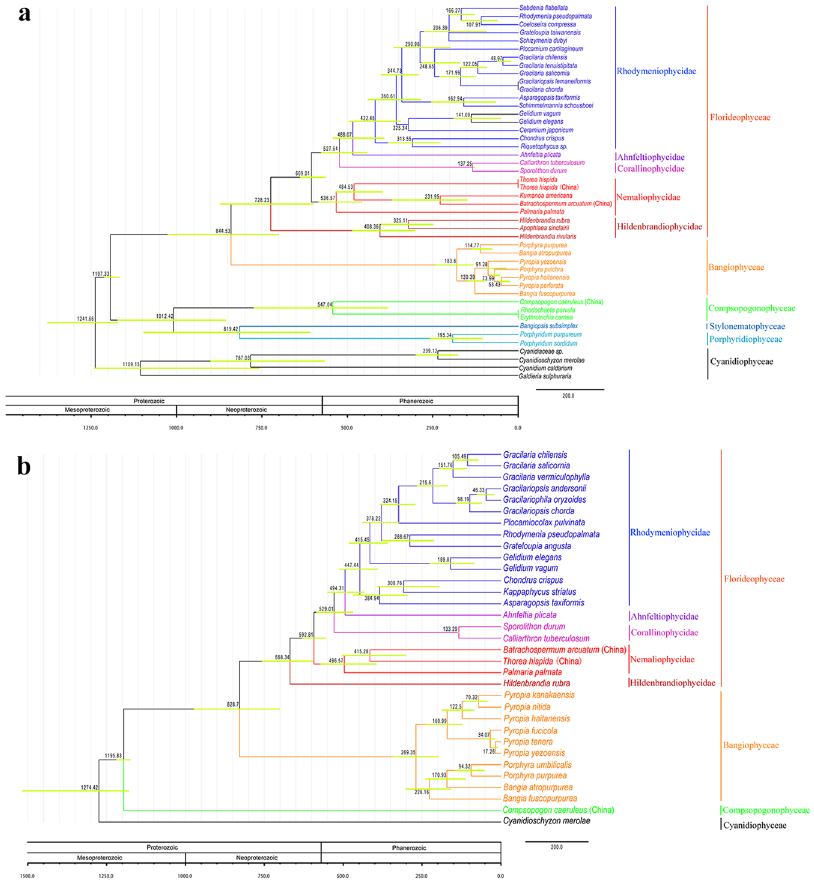
Figure 5. Divergence time estimation phylogram based on organelle genome sequence. Numbers at the nodes represent the mean estimated divergence time with the corresponding 95% highest posterior density (HPD) of the nodes indicated by horizontal bars. The geological timescale is given in million years ago (MYA). ( a ) Divergence time estimation tree based on the chloroplast genome sequence. ( b ) Divergence time estimation tree based on the mitochondrial genome